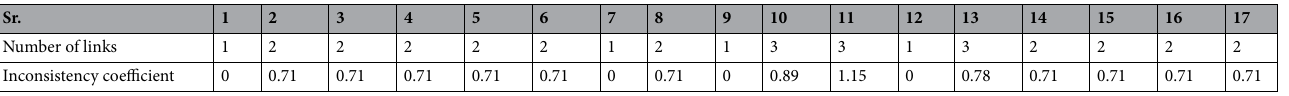
Table 4. Inconsistency measure for links in dendrogram.